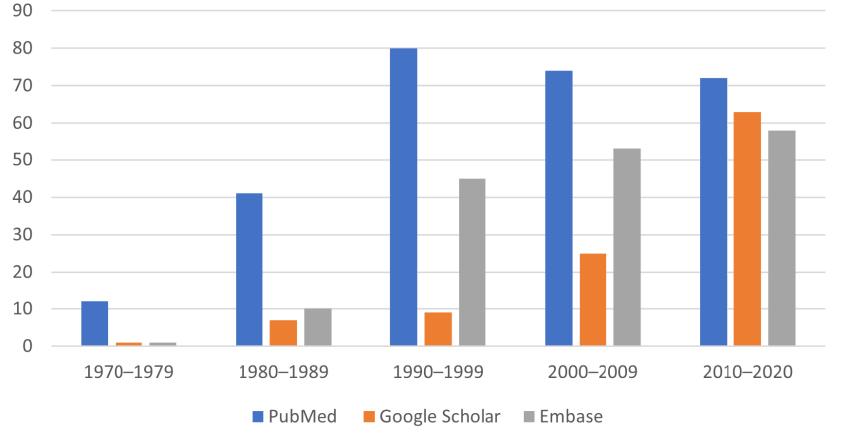
Figure 3. Numerousness of studies on CHF in dogs found in each database and in all decades.